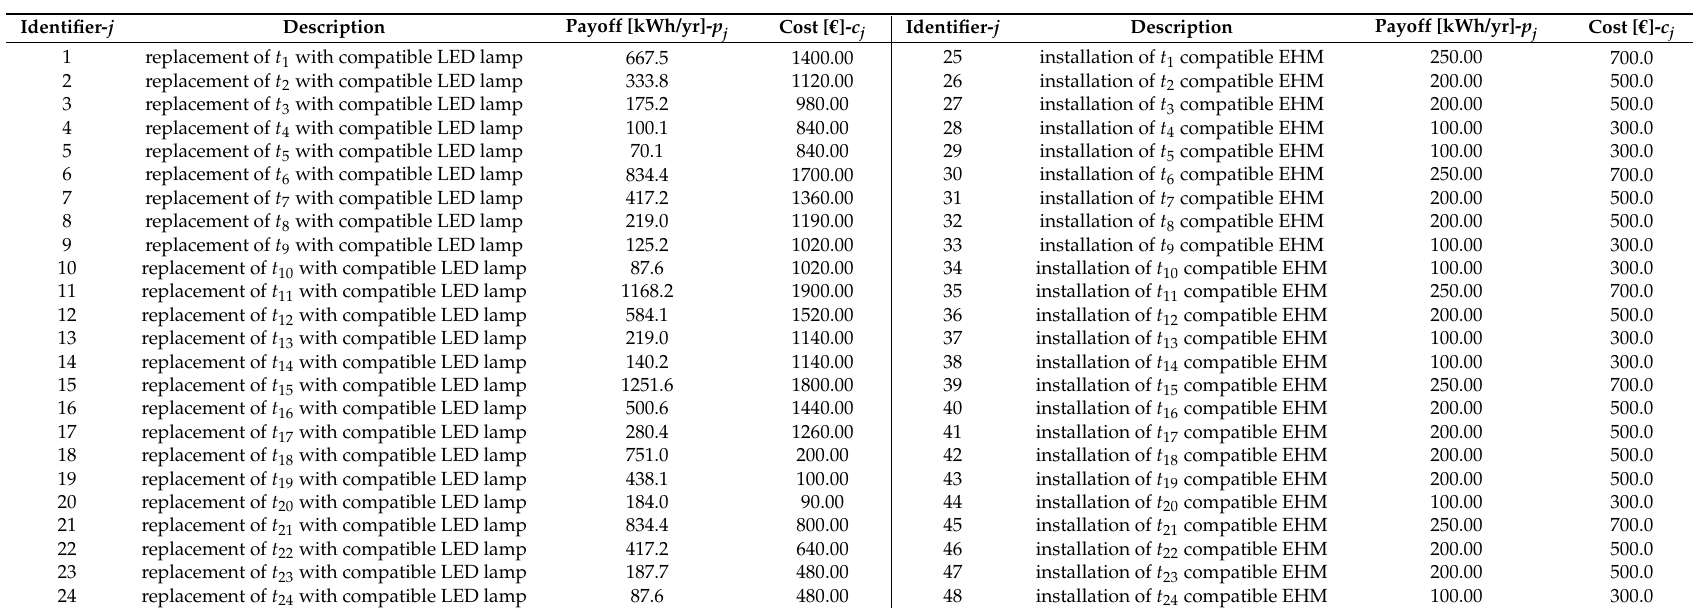
Table 2. Costs and payoffs of retrofit